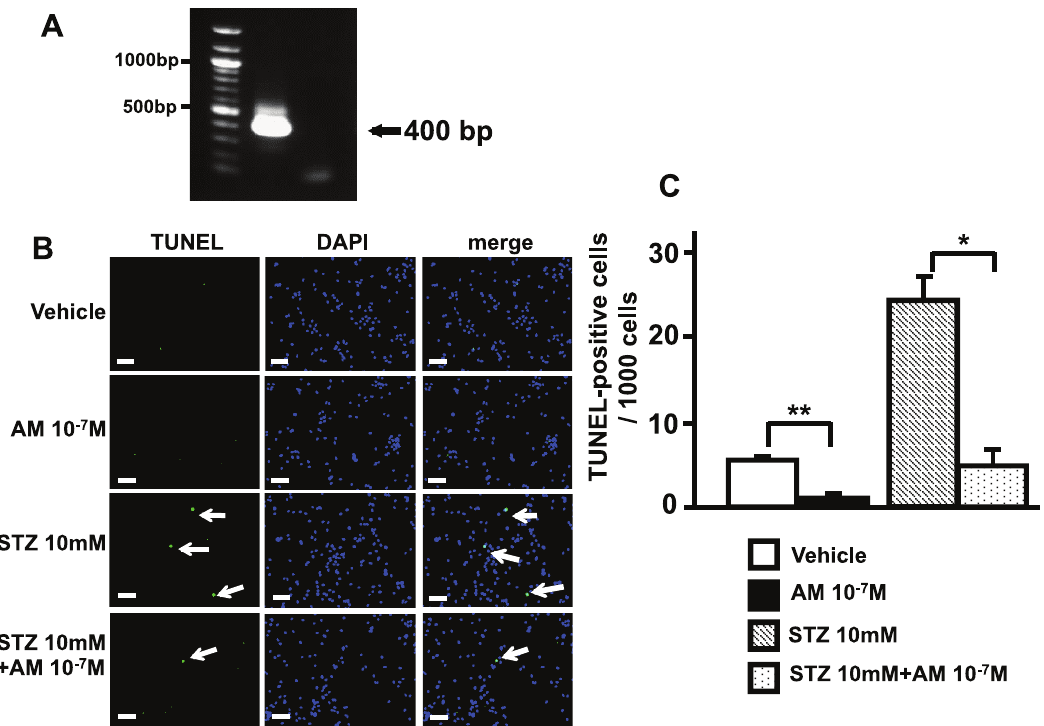
Figure 4. AM suppresses STZ-induced apoptosis among human renal tubule cells (RPTECs). (A) RT-PCR analysis showing the expression of GLUT2 in RPTECs. The arrow indicates the GLUT2 PCR product. (B) TUNEL assays of cultured RPTECs treated with vehicle, AM, STZ, or STZ + AM. Arrows show the TUNEL-positive cells. Scale bars=100 m m. (C) Numbers of TUNEL-positive cells per 1,000 cultured cells. The experiments were repeated 3 times. Bars are means 6 SEM. *p , 0.05, **p , 0.01.